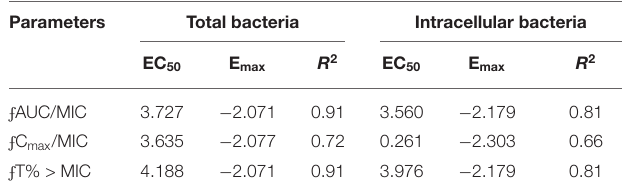
TABLE 5 | The parameters required to achieve bacterial stasis or 1 log 10 kill or 2 log 10 kill for total bacteria and intracellular